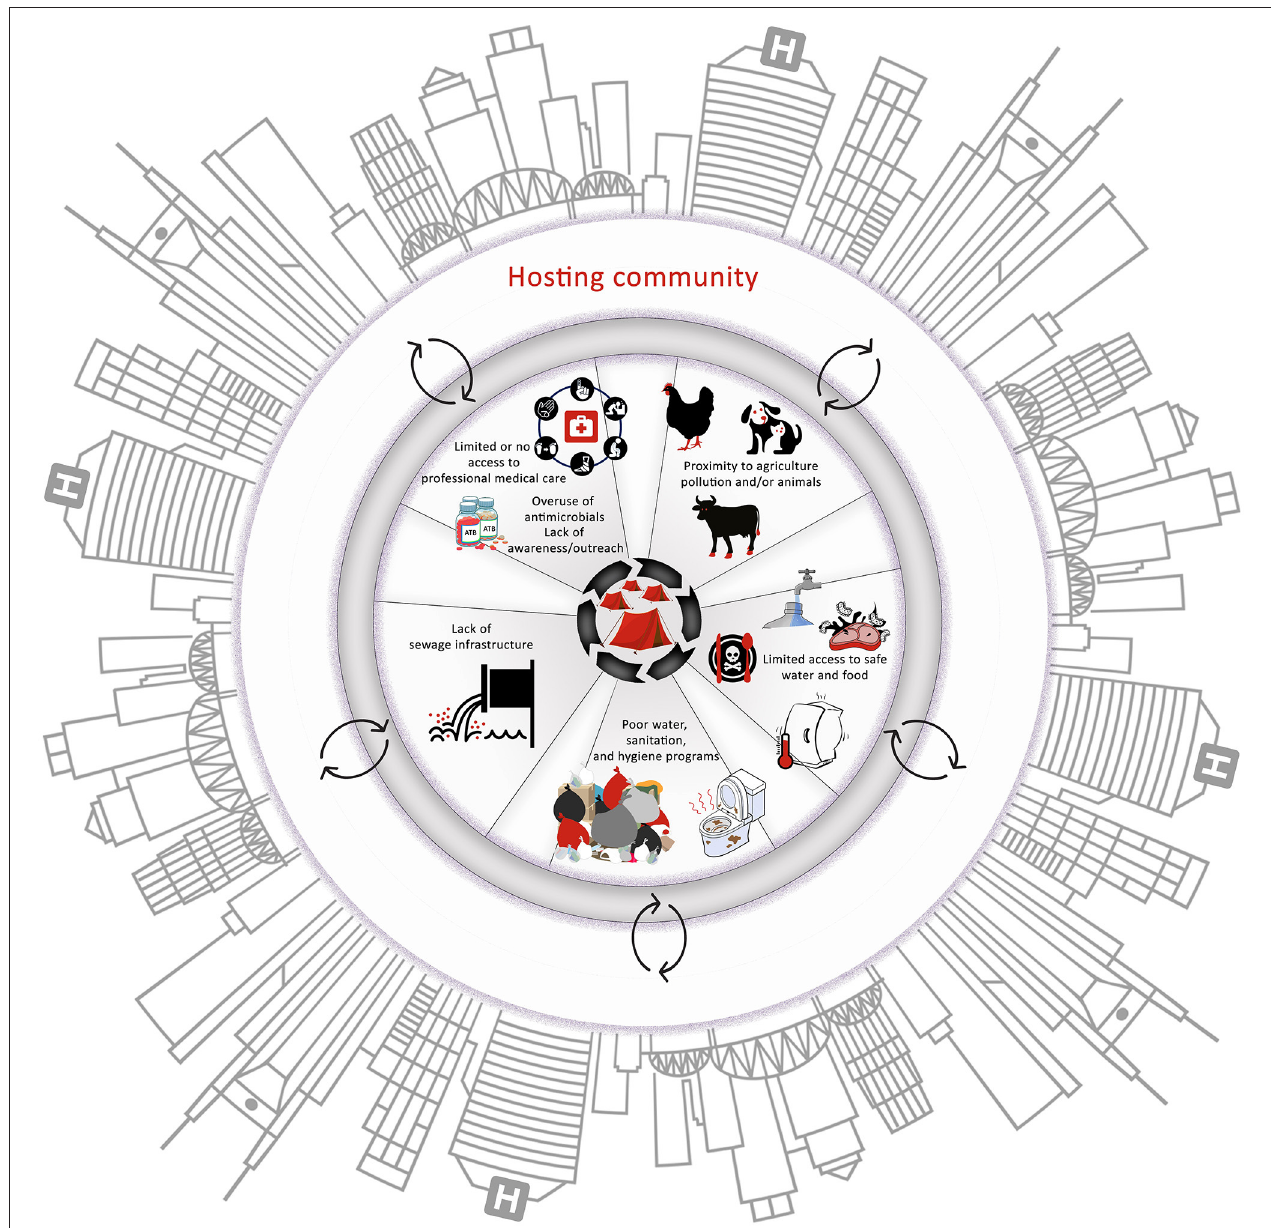
FIGURE 2 | The major factors that influence the emergence and spread of antimicrobial-resistant pathogens in the camps. It is important to note the interactions between all the factors and between the camps and the hosting community. These interactions can create suitable conditions for the emergence and rapid spread of antimicrobial resistance (AMR) within camps and hosting communities, highlighting the necessity to adopt a One Health approach to tackle AMR in these scenarios.